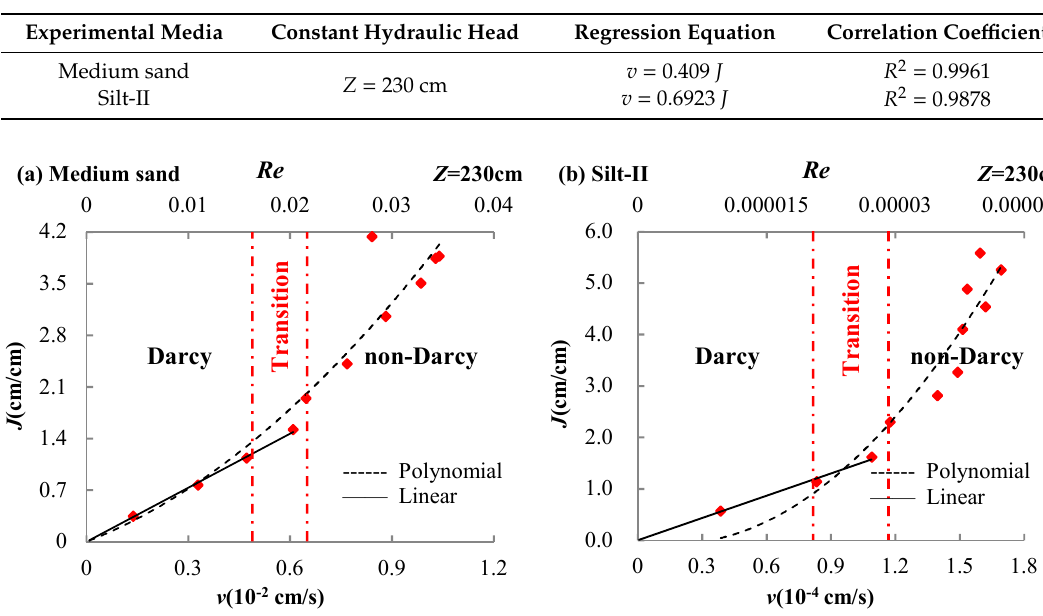
Table 5. Linear equations and correlation coe ffi cients of initial data of Medium sand and Silt-II.